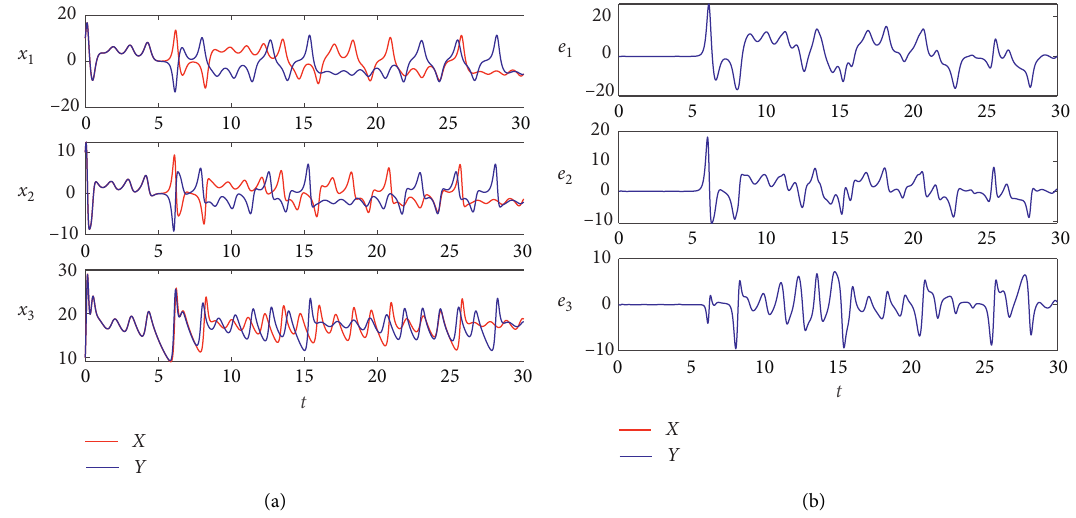
Figure 1: The chaotic phenomenon of system (1) with the initial condition ( x series of x i , i � 1, 2, 3.